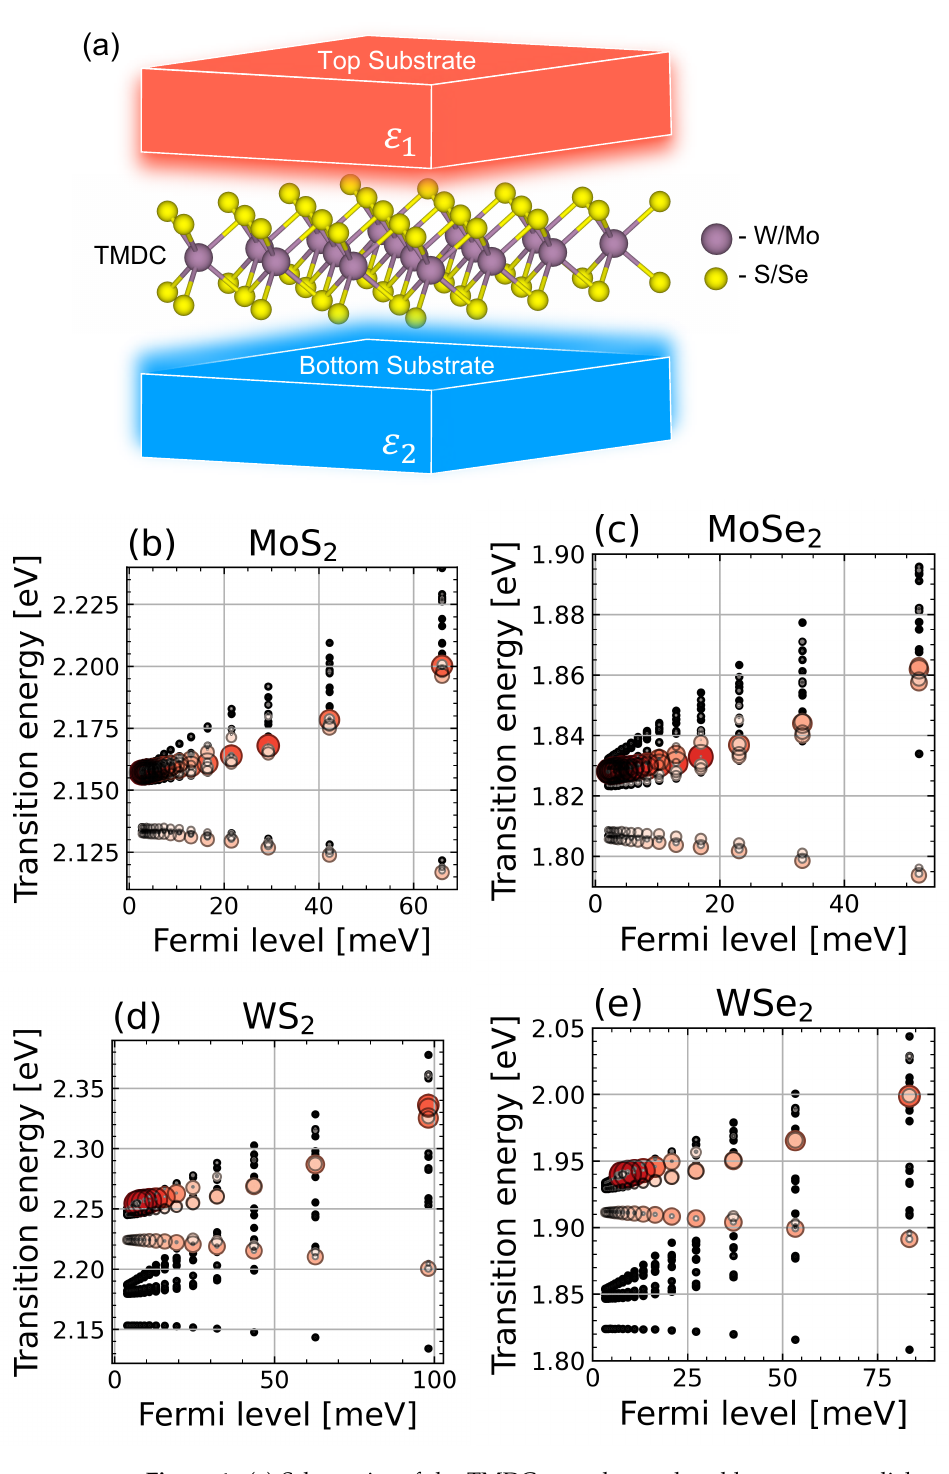
Figure 1. ( a ) Schematics of the TMDC monolayer placed between two dielectrics that define en- vironmental screening ε env = ( ε 1 + ε 2 ) /2. ( b – e ) Energy diagram of the transition energies of the three-particle states calculated in freestanding ( ε env = 1) ML of MoS2 ( b ), MoSe2 ( c ), WS2 ( d ), and WSe2 ( e ) as a function of the Fermi level. Circle centers denote optical transition energies of trions. Colors and widths indicate their oscillator strengths (red) for bright states and (black) for dark ones. “Trion” and “exciton” denote trion and exciton states, depending on whether the second electron in the three-particle wavefunction is bound or